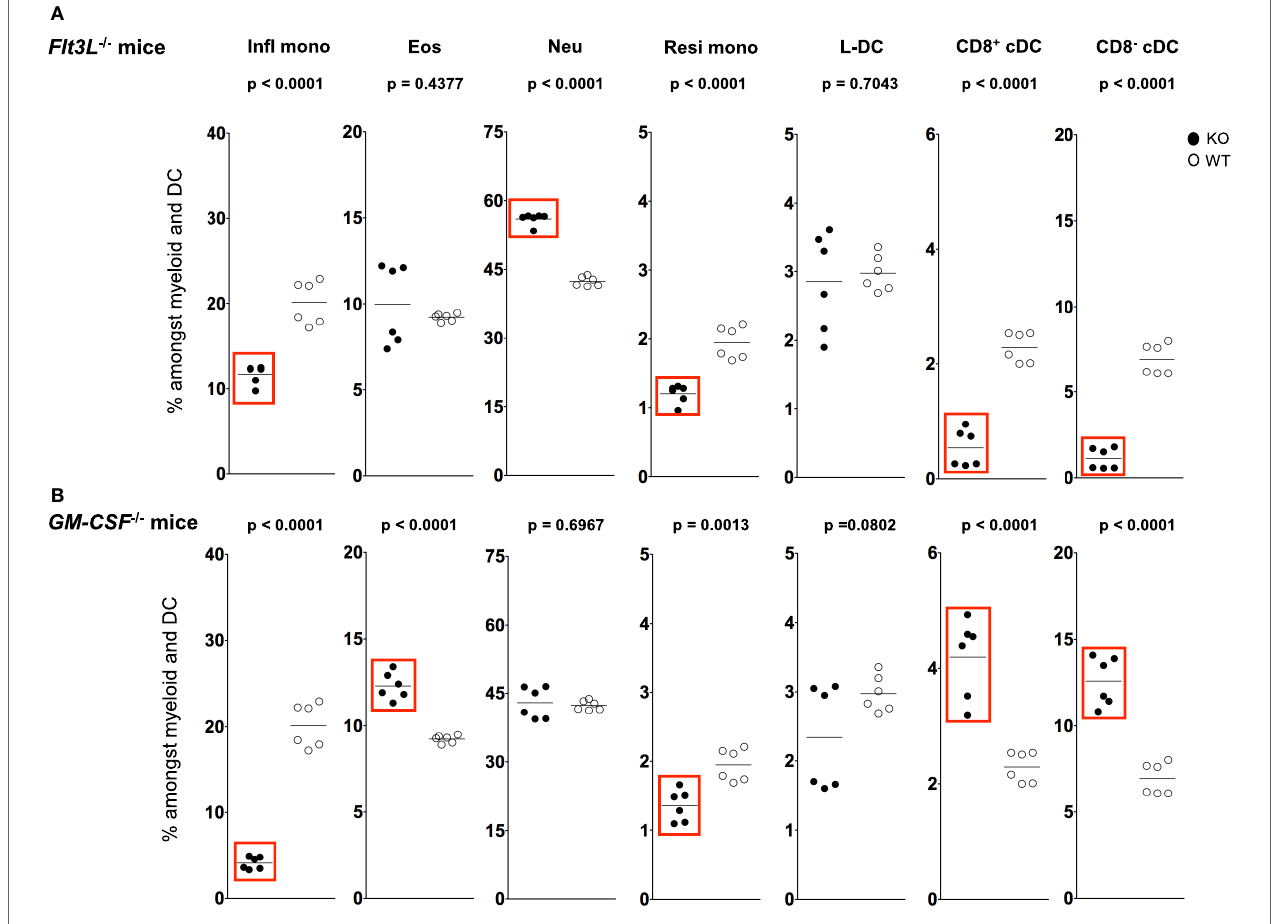
FigUre 5 | l-Dc development occurs independently of Flt3l and gM-csF . Splenocytes were harvested from C57BL/6J- Flt3L tm1lmx (Flt3L − / − ), C57BL/6J- Csf2 tm1Ard (GM-CSF − / − ), and C57BL/6J (wild-type) mice, and prepared as described in Figure 1 . Cells were stained with two distinct antibody cocktails and propidium iodide (PI) as described in Figure 4 . Subset size was estimated as % of total DC and myeloid population in individual wild-type mice (WT) compared with (a) Flt3L − / − and (B) GM-CSF − / − mice (KO). A bar is used to show mean values and p values are given. Statistically different subsets ( p ≤ 0.05) are